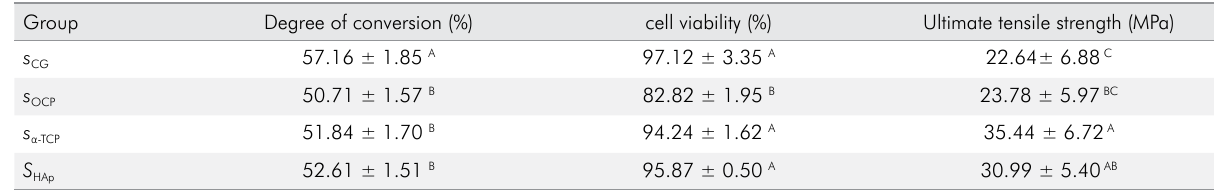
Table 2. Degree of conversion (%), cell viability (%) and ultimate tensile strength means and standard deviations. Group Degree of conversion